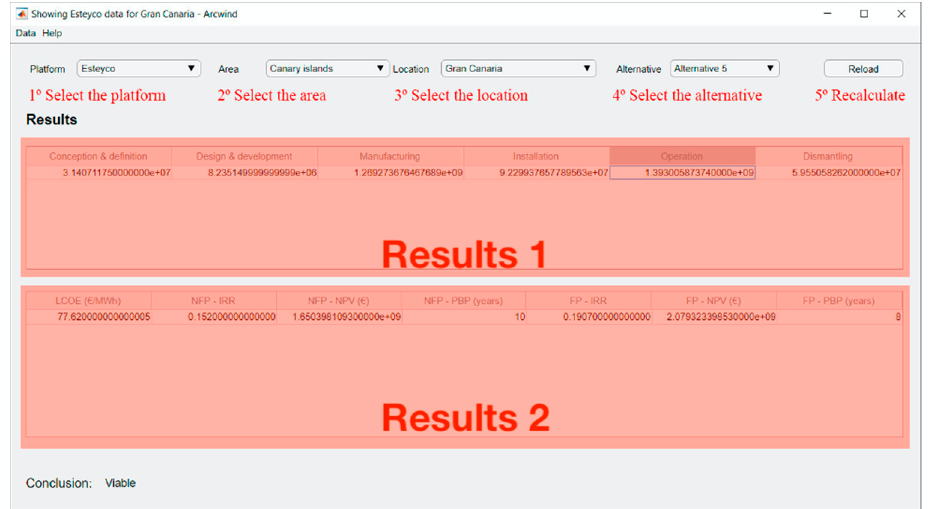
Figure 3. Main window of the software and types of the results depending on the scenario selected.